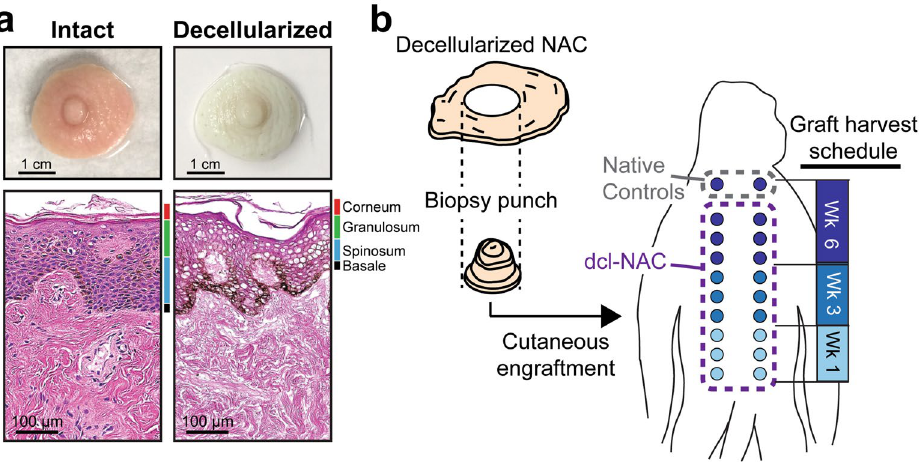
Figure 1. Intact donor NAC vs. decellularized dcl-NAC, and overview of in vivo NHP engraftment study. ( a ) Gross images and H&E sections show an intact donor NAC (left panels) and a decellularized dcl-NAC (right panels). Note that dcl-NAC retains ECM structure and defined dermal layers, and lacks cellular components like DNA (purple staining in lower panels, DNA; brown coloration in strata basale, endogenous melanin). ( b ) Experimental overview: dcl-NACs were biopsy punched to a standard size and engrafted along the dorsal midline of rhesus macaque hosts with the animal’s own two intact, non-decellularized, native nipples as surgical controls. Grafts were harvested at weeks 1, 3, and 6. This was drawn by Vincent